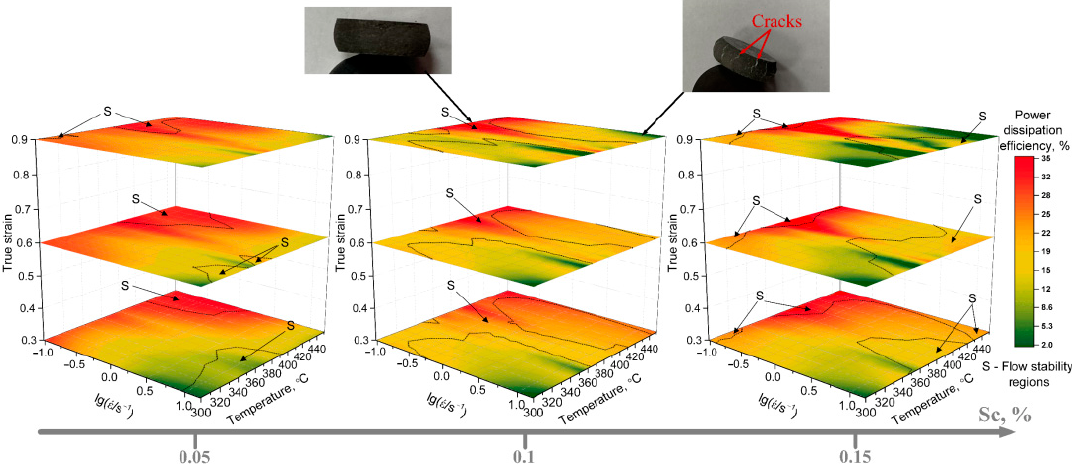
Figure 4. 3D processing maps for Al4.5Zn4.5Mg1Cu0.12Zr alloys with different Sc contents, and images of 0.1Sc alloy specimens after deformations at 450 °C/15 s − 1 (with cracks) and 400 °C/0.1 s − 1 (without cracks).